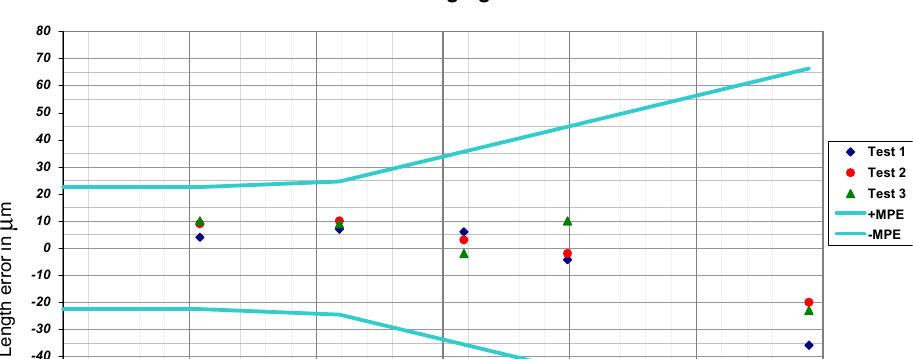
Fig. 6. Interferometer ranging test results. ADM Ranging Test